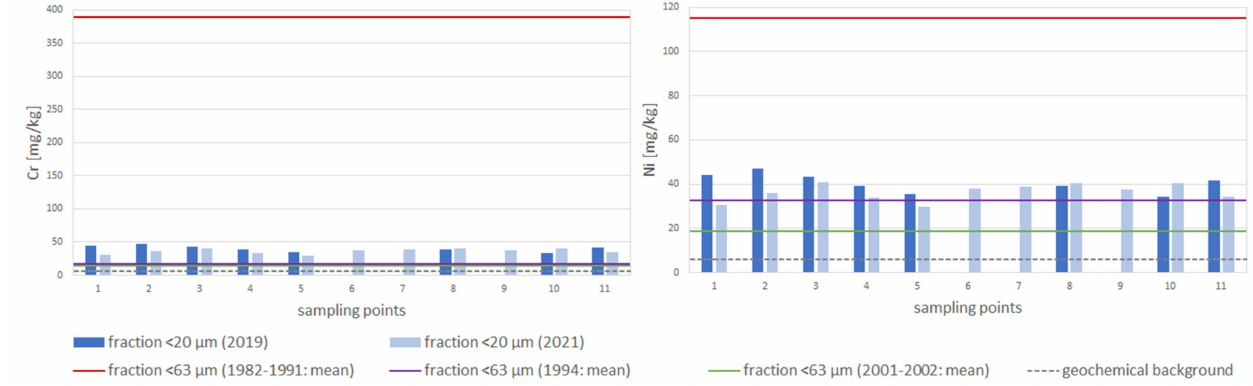
Figure 5. Comparison of selected metal concentrations (Cr and Ni) in Wilga River bottom sediments (fraction <20 µ m; 2019 and 2021) with geochemical background [87] and with data from previous studies: mean concentrations in fraction <63 µ m from two sampling campaigns (1982–1991 and 1994), according to [56] and mean concentrations in fraction <63 µ m from sampling campaign 2001–2002, according to